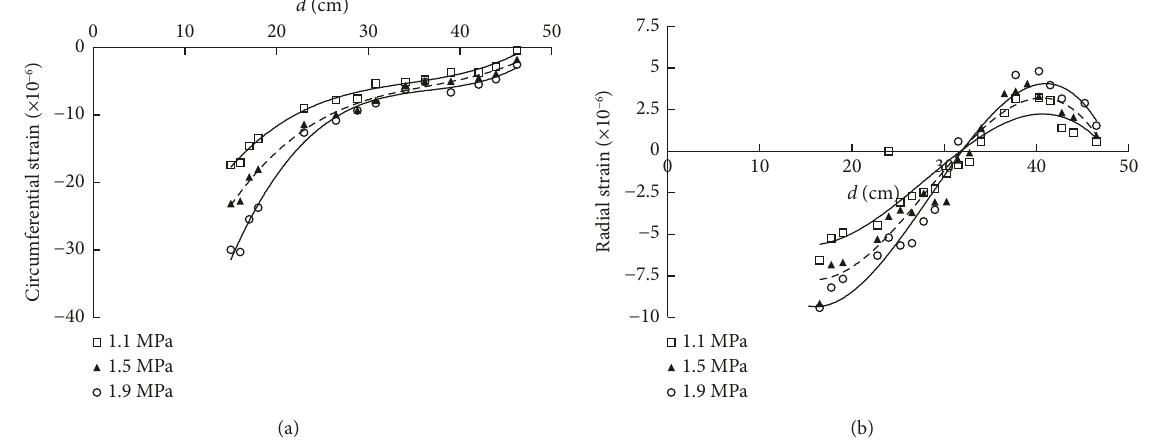
Figure 18: Strain test results of the CSM pavement structure model under the different load levels. (a) Circumferential strain. (b) Radial strain.